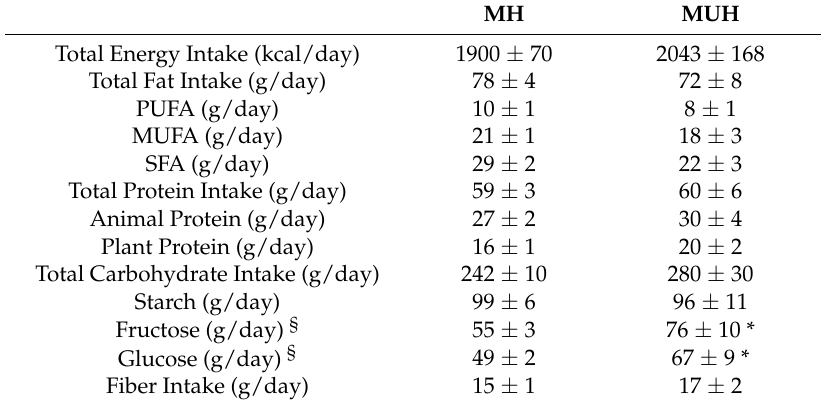
Table 3. Nutritional Intake of healthy children and children suffering from metabolic disorders.